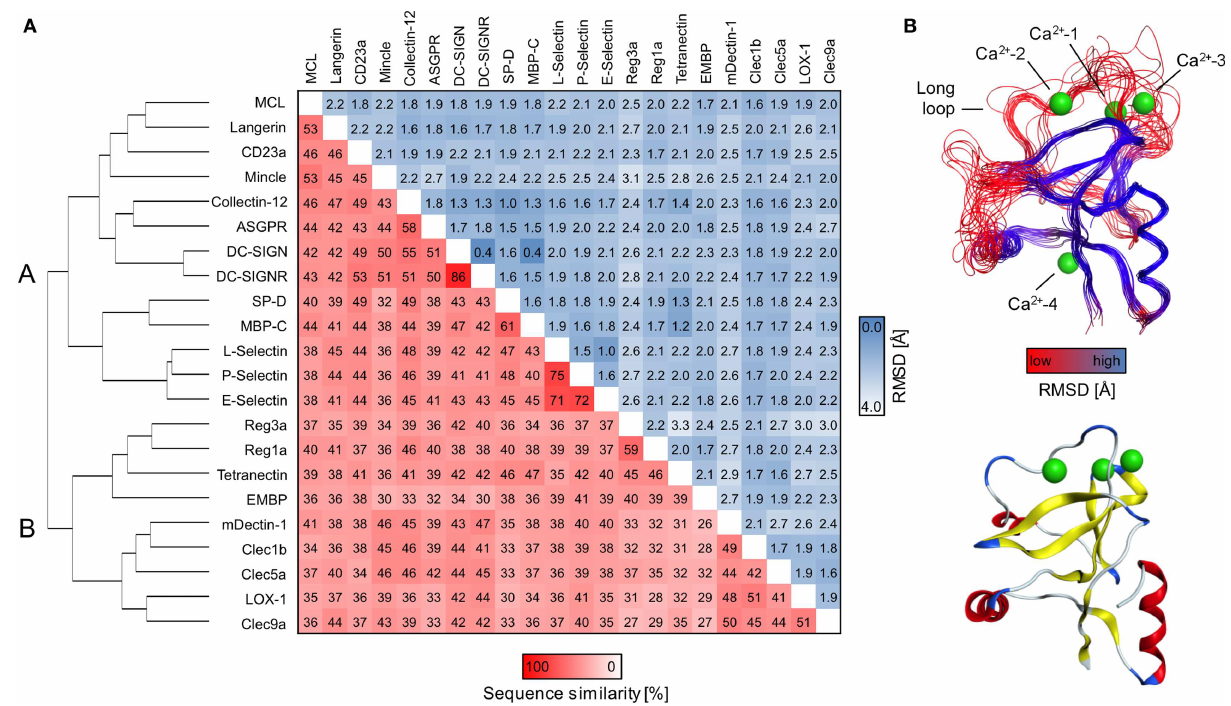
FIGURE 1 | Sequence alignment and consensus structure of CTLRs . (A) The dendrogram depicts the hierarchical clustering of CRDs based on a structure-based multiple sequence alignment.The two major branches are termed cluster A and B. Pairwise sequence similarities and RMSDs of C α atoms are shown in matrix format. (B) Key structural features of the CTLD